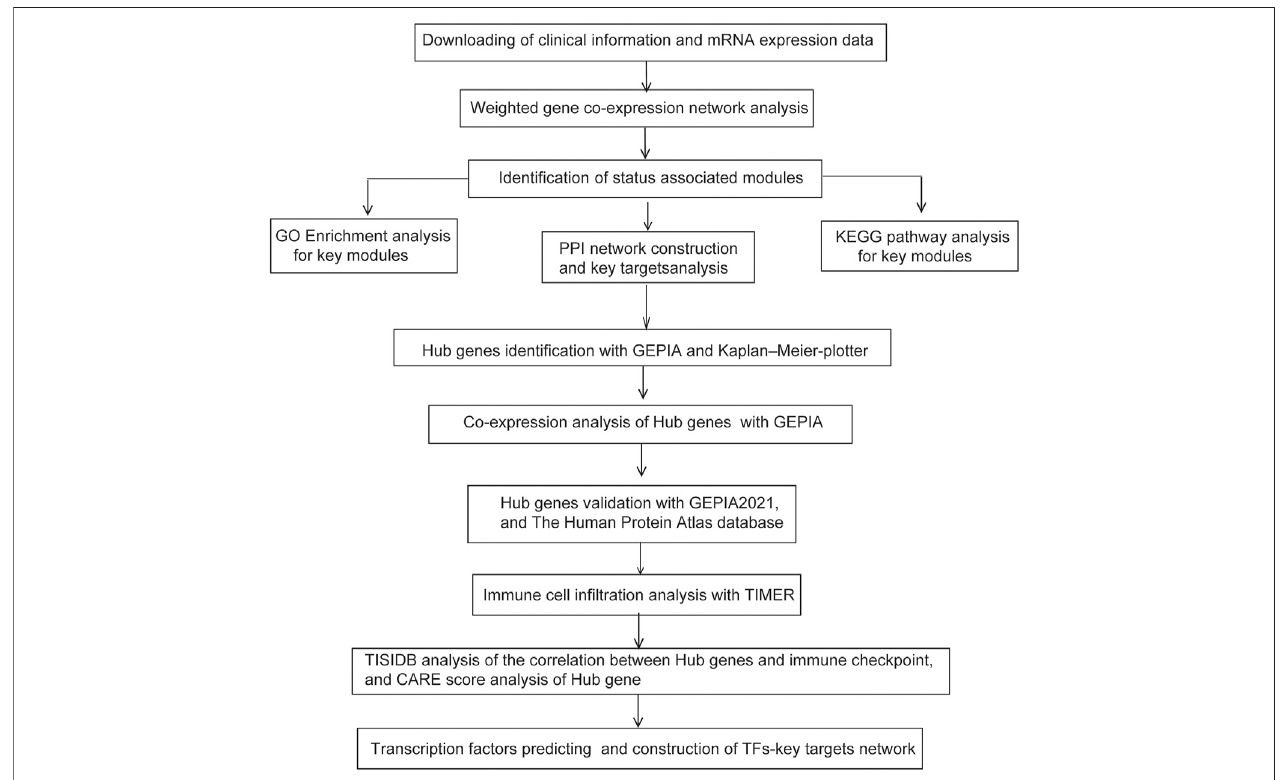
FIGURE 1 | Experimental design and work fl ow of our